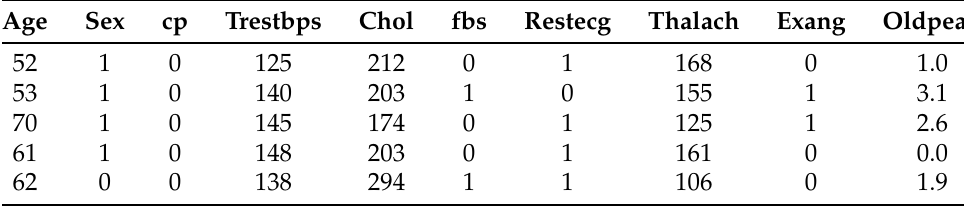
Table 2. First five rows of heart disease